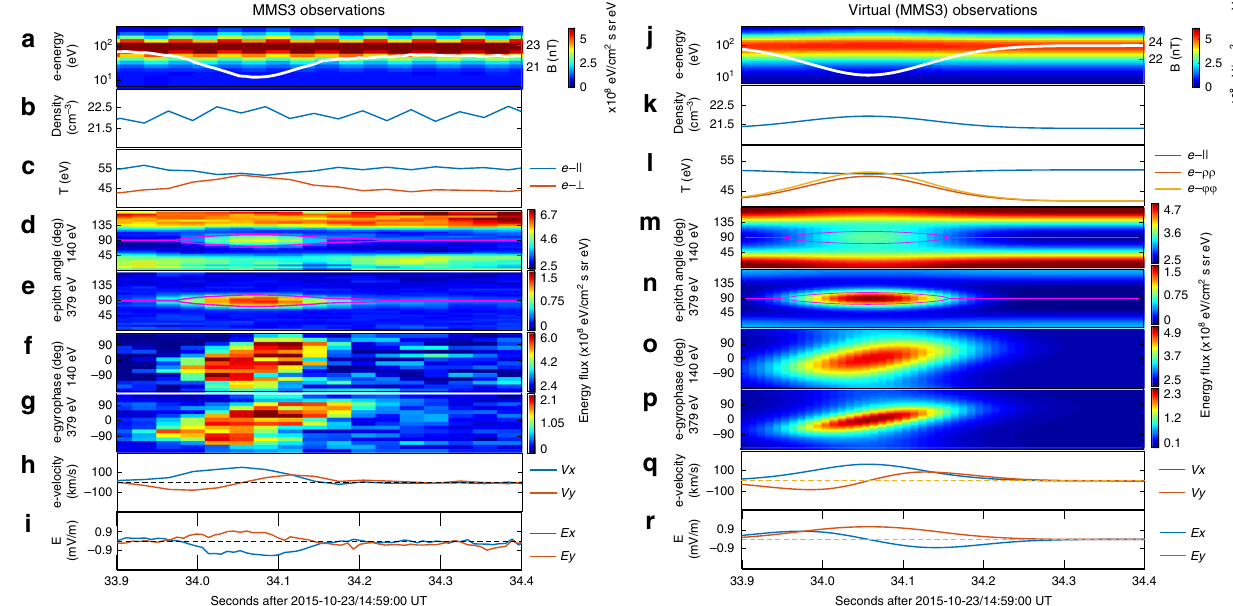
Fig. 3 The MMS3 observations of the electron-scale magnetic cavity in comparison with virtual spacecraft observations of the modeled cavity. Panels a – i and j – r , both in the same format as in Fig. 1 e – m , are the MMS3 and the virtual spacecraft observations, respectively.